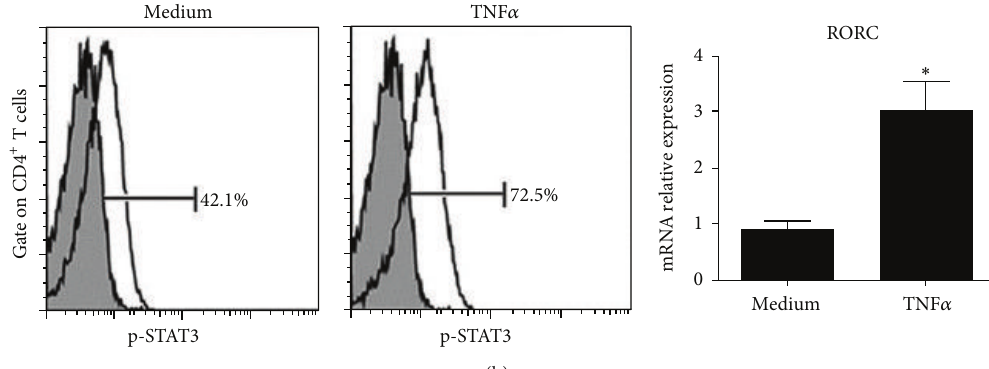
Figure 4: Role of TNF 𝛼 in the Th17 cell differentiation through IL-6 and IL-1 𝛽 in CD14 + monocytes. (a) CD4 + T cells purified from PBMC of healthy individuals were cultured with RA SF (dilution 1: 8) in the presence or absence of the indicated antibodies in presence of anti-CD3 and anti-CD28 for 5 days. Percentage of Th1 and Th17 cells was analyzed in CD4 subset by flow cytometry. (b) FACS-sorted CD4 + CD45RA + CD25 − na¨ıve T cells from healthy individuals were stimulated with the indicated conditions for 5 days and intracellular staining of IL-17 was analyzed by flow cytometry (up row) and the supernatant was collected for IL-17 detection by ELISA (down row). (c) CD14 + monocytes purified from PBMC of healthy individuals were cultured overnight with RA SF in the presence or absence of the indicated antibodies. The resulting cells were cocultured with CD4 + T cells derived from the same donor in presence of anti-CD3 and anti-CD28 for 5 days. Percentage of Th17 cells was analyzed in CD4 subset by flow cytometry. (d) TNFRI and TNFRII expression levels were detected by flow cytometry gated on the CD14 + monocytes from the healthy individuals. Bars show the mean and SEM. (e) Purified CD4 + T cells derived from healthy individuals were cocultured with CD14 + monocytes with different ratios in the presence of TNF 𝛼 (50 ng/mL) for 5 days and percentage of Th17 cells was analyzed in CD4 subset by flow cytometry. (f) Purified CD4 + T cells derived from healthy individuals were cocultured with CD14 + monocytes in the presence of TNF 𝛼 and the indicated antibodies for 5 days. Percentage of Th17 cells was analyzed in CD4 subset by flow cytometry. (g) Purified CD4 + T cells and CD14 + monocytes from healthy individual were cocultured with TNF 𝛼 or not. After being cultured for 5 days, percentage of IL-6 or IL-1 𝛽 producing cells was analyzed in CD14 + cells by flow cytometry. (h) In the same experiment setting as in (g), STAT3 phosphorylation in the CD4 + T cell population was analyzed by flow cytometry (left panel) after 24 h culture and mRNA abundance of RORC was determined by real-time PCR (right panel) after 18h culture. Bars show the mean ± SEM. ∗ 𝑃 < 0.05 versus medium